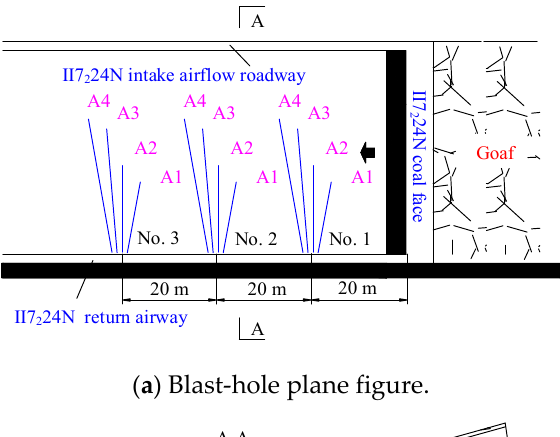
15 Table 6. Parameters of blasting explosives. Type of Explosive Detonator Type